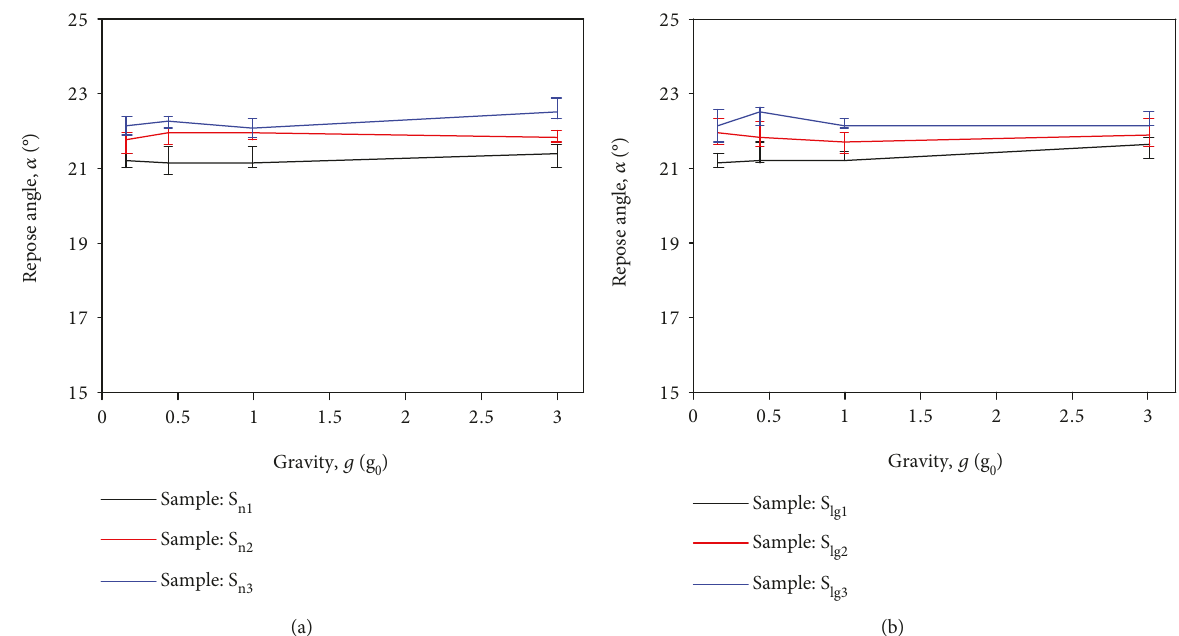
Figure 6: Repose angle of particulate pile under di ff erent gravity conditions for (a) particle samples with normal size distributions and (b) particle samples with lognormal size